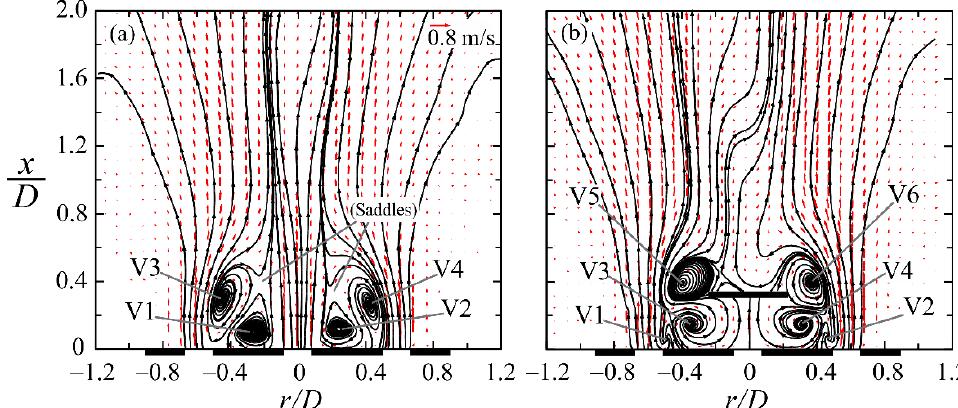
Figure 4. Velocity vectors and streamline patterns of swirling double-concentric jets. Re c = 280, Re a = 480, and S = 0.432. ( a ) One centerbody, ( b ) two centerbodies.